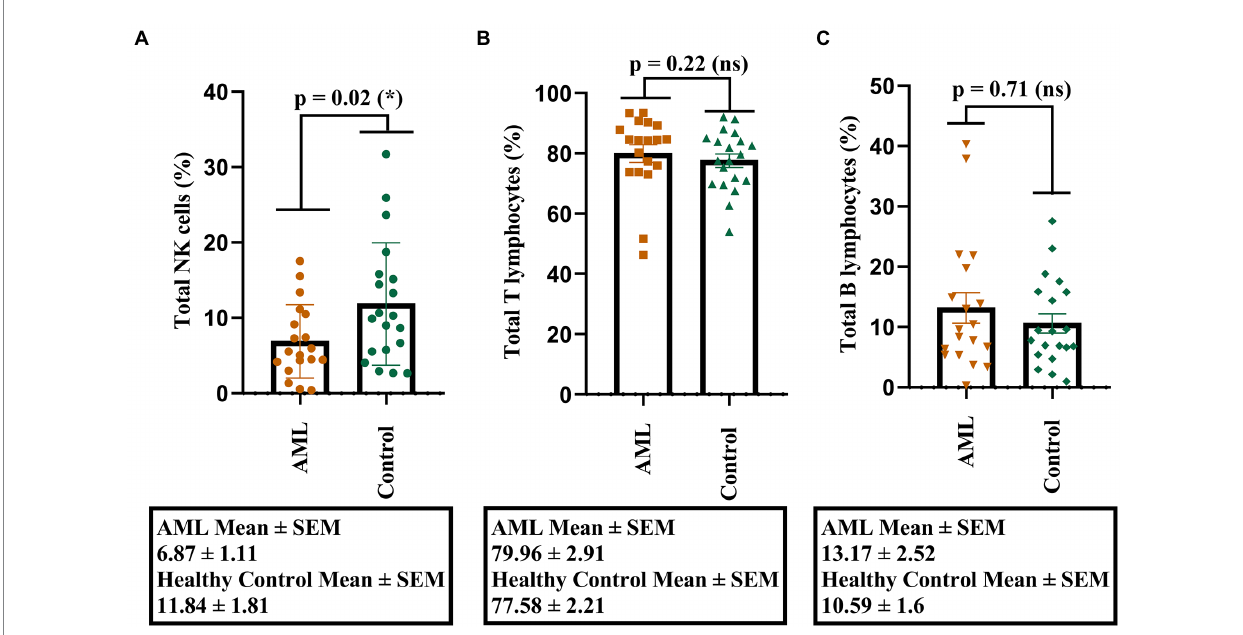
FIGURE 1 Percentage of lymphocytes in AML and healthy controls. (A) Comparison between the NK cell percentages (%) in AML ( n = 19) and healthy control ( n = 20) cases. (B) Comparison between the T cell percentages (%) in AML ( n = 19) and healthy control ( n = 20) cases. (C) Comparison between the B cell percentages (%) in AML ( n = 19) and healthy control ( n = 20) cases. Bars represent the mean ± SEM ( p < 0.05 (*); ns, not significant; two tailed unpaired t